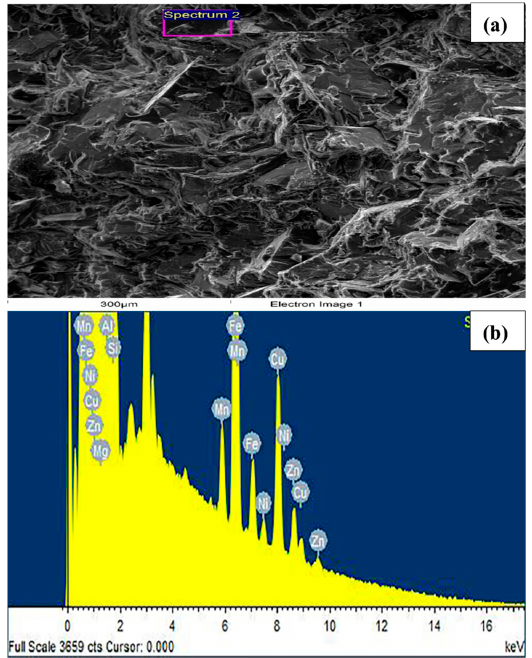
Figure 6. SEM images and EDS spectra show the chemical composition of base aluminum alloy ( a ). Spectra on the SEM image of the base alloy ( b ) with phases of iron, magnesium, zinc, silicon, and copper.